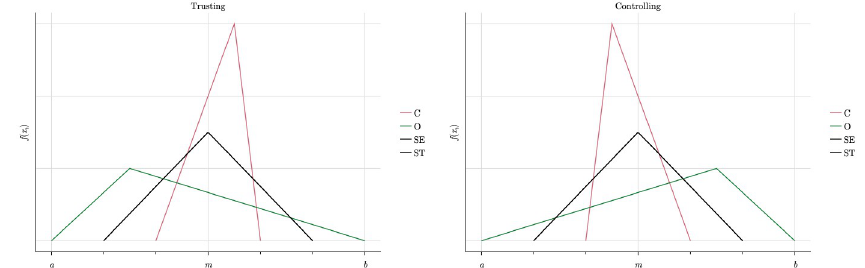
Fig 6. Deviations from shirking norm in different organisational